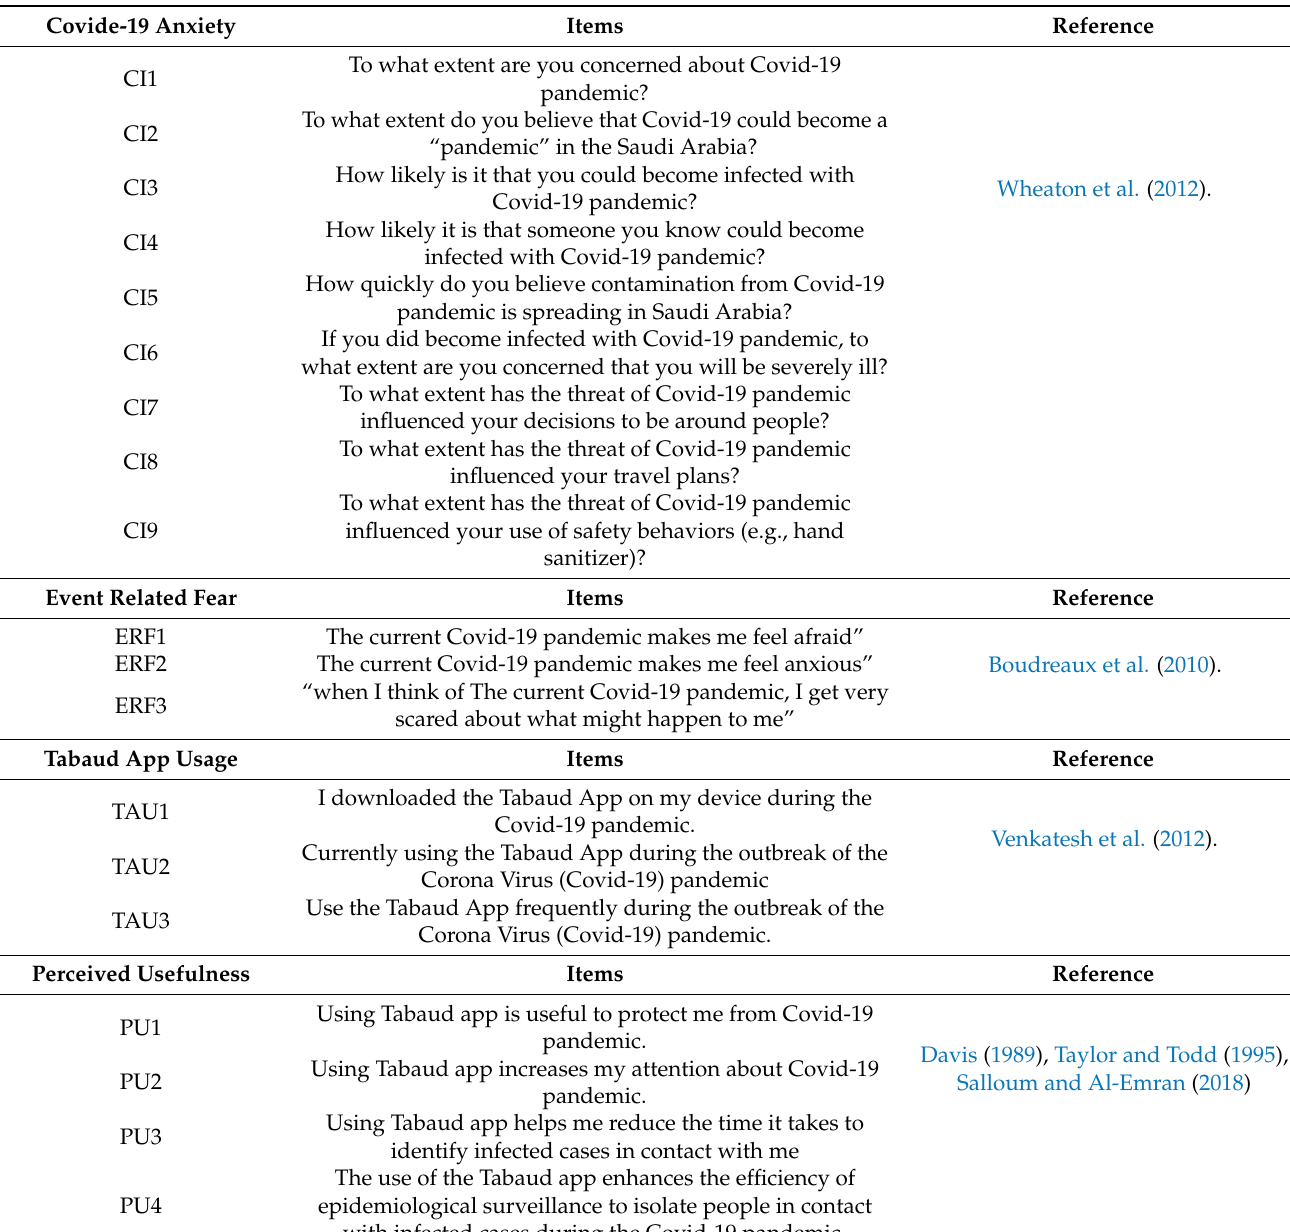
Table A1. Variables with measurement items